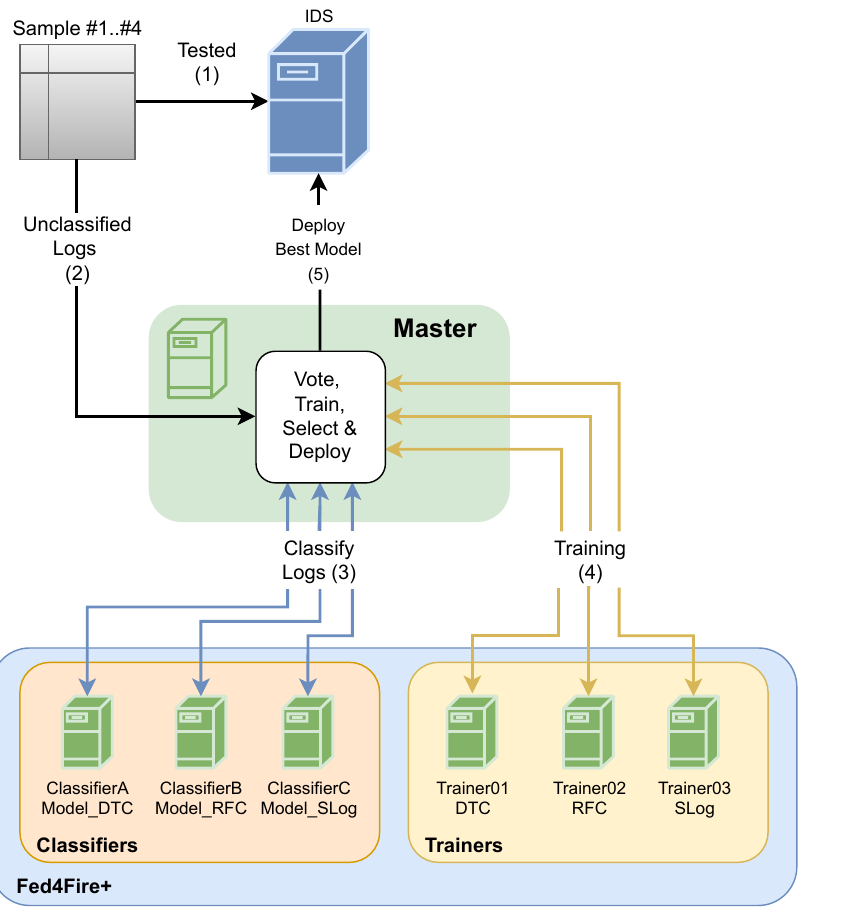
Figure 8. Proposed architecture scenario.